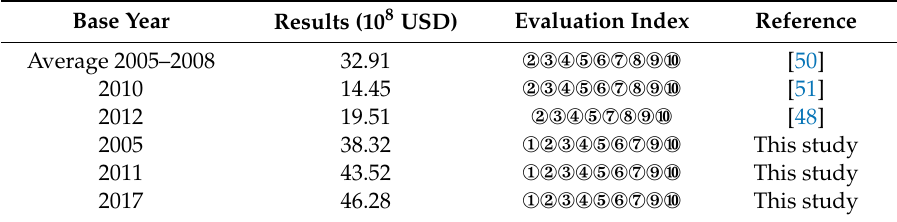
Table 4. Di ff erences to other studies on the assessment of wetland ecological services in the Nansi Lake Wetland 1